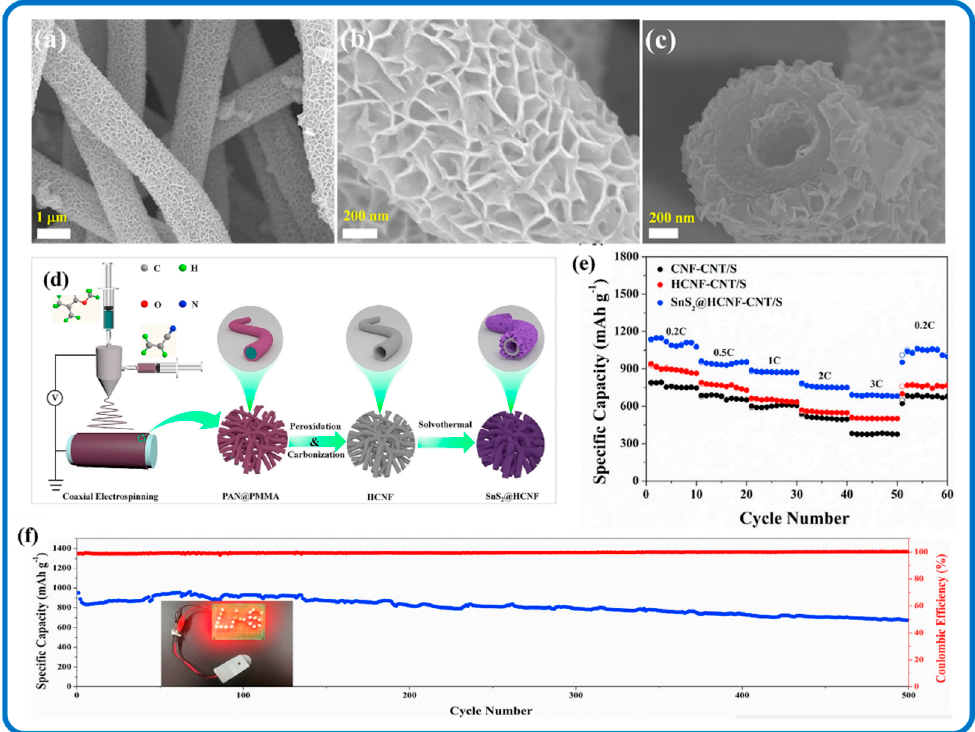
Figure 18. ( a – c ) SEM and TEM images, ( d ) schematic diagram of SnS 2 @HCNF synthesis, and ( e , f ) electrochemical performance of Li-S batteries with different interlayers. Reproduced with permission from [239]. Copyright 2021, Elsevier.